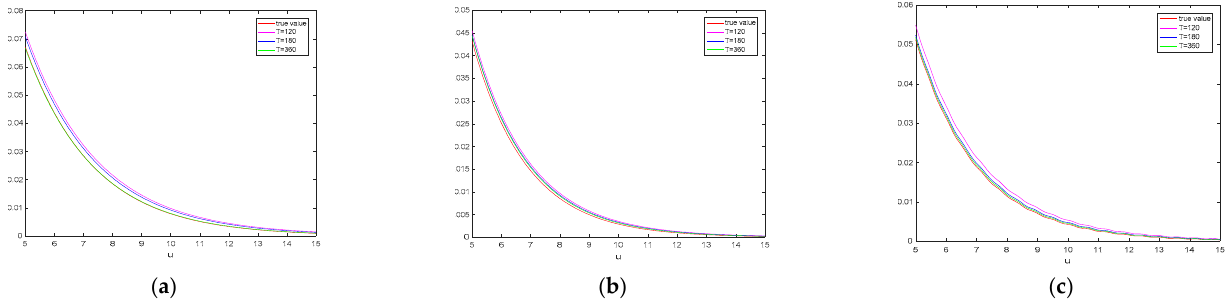
( c ) Figure 5. Estimation of the ruin probability: mean relative error curves. ( a ) Exponential claim size density; ( b ) Erlang (2) claim size density; ( c ) Gamma (1.5,1.5) claim size density. Figure 6. A partial enlargement of the mean curves for the estimation of the ruin probability under the Gamma (1.5, 1.5) distribution. 15